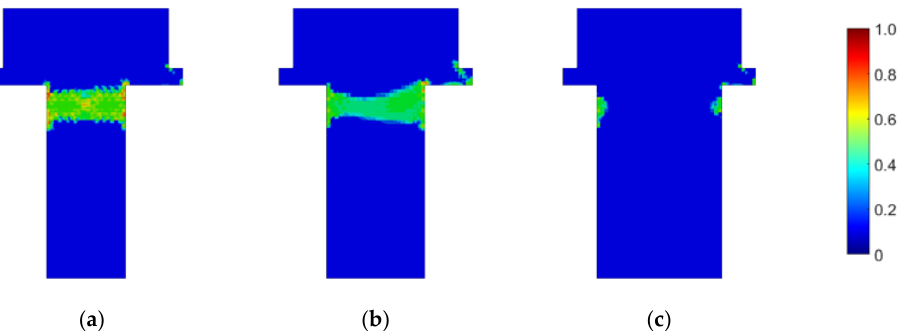
Figure 14. Fatigue distribution of the normalized logarithmic life repeats in the nutless bolt for the model with a bolt diameter of: ( a ) 8.2 mm; ( b ) 10.2 mm; ( c ) 13 mm.